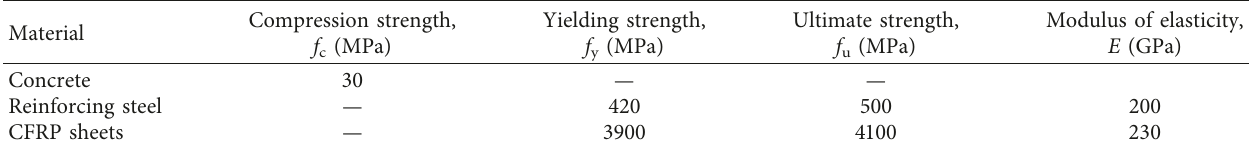
Table 3: Material properties of concrete, steel rebars, and CFRP